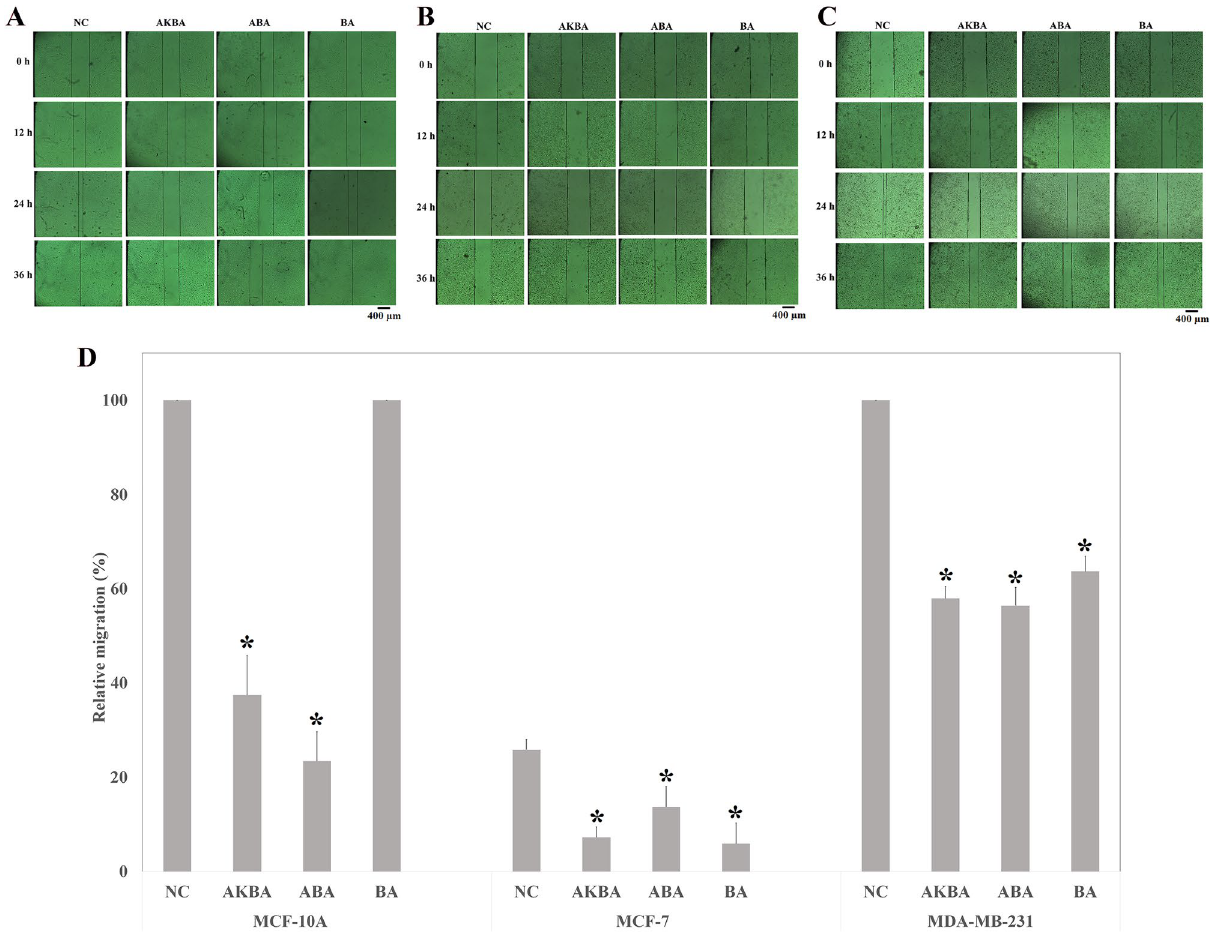
Figure 3. Scratch migration assay. The photos were taken 12, 24 and 36 h after treatment. ( A ) Scratch closure in MCF-10A cells treated with AKBA, ABA, and BA compared with the negative control (NC). ( B ) Scratch closure in the MCF-7 cells treated with AKBA, ABA, and BA compared to the NC. ( C ) Scratch closure in the MDA-MB-231 cell line treated with AKBA, ABA, and BA compared to the NC. ( D ) Quantitative analysis of treated- and non-treated- MCF-10A, MCF-7, and MDA-MB-231 cells’ migration. *indicates a significant difference compared to the NC (P < 0.05) (N value =